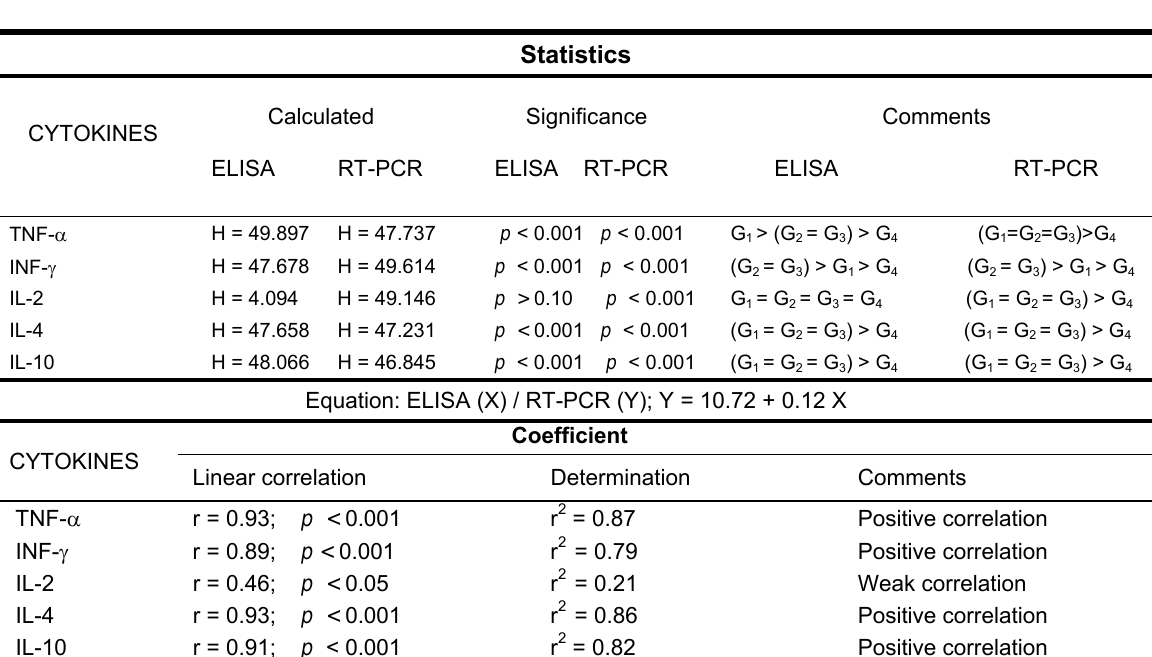
Table 1. Comparison and correlation of cytokine values in serum (ELISA) and in mononuclear cells (RT-PCR) in HIV-1 infected patients and normal individuals distributed into groups